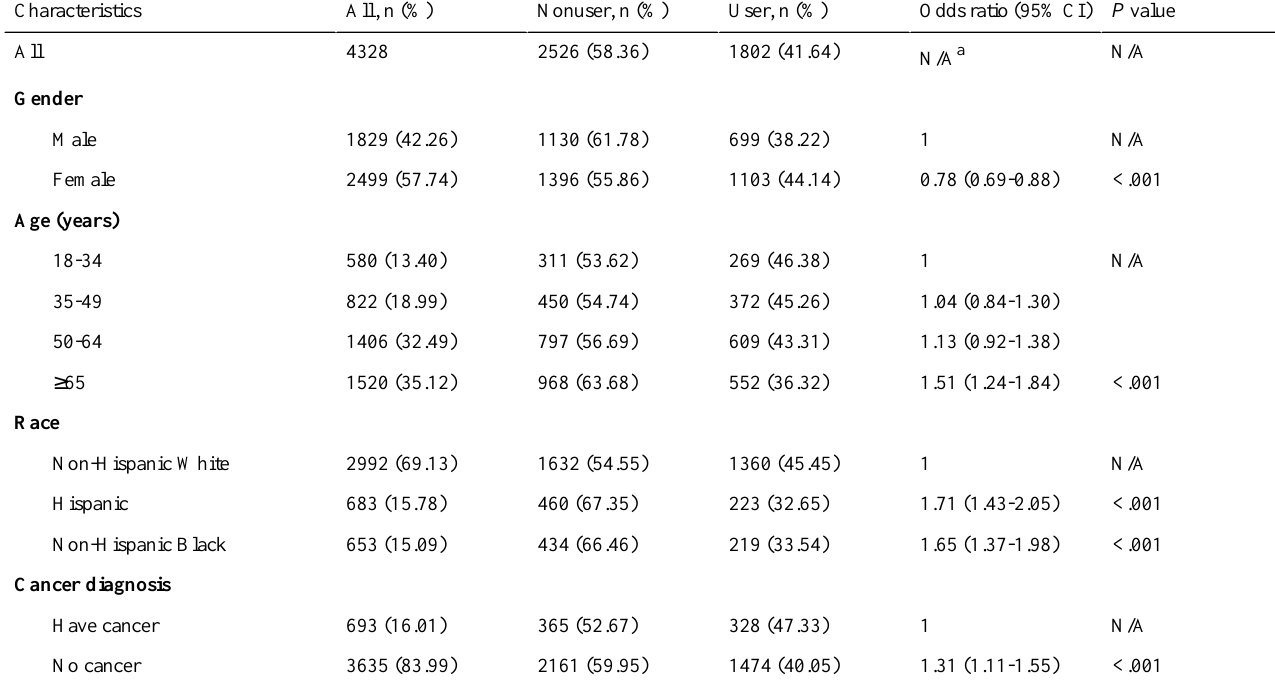
Table 3. Use of online medical